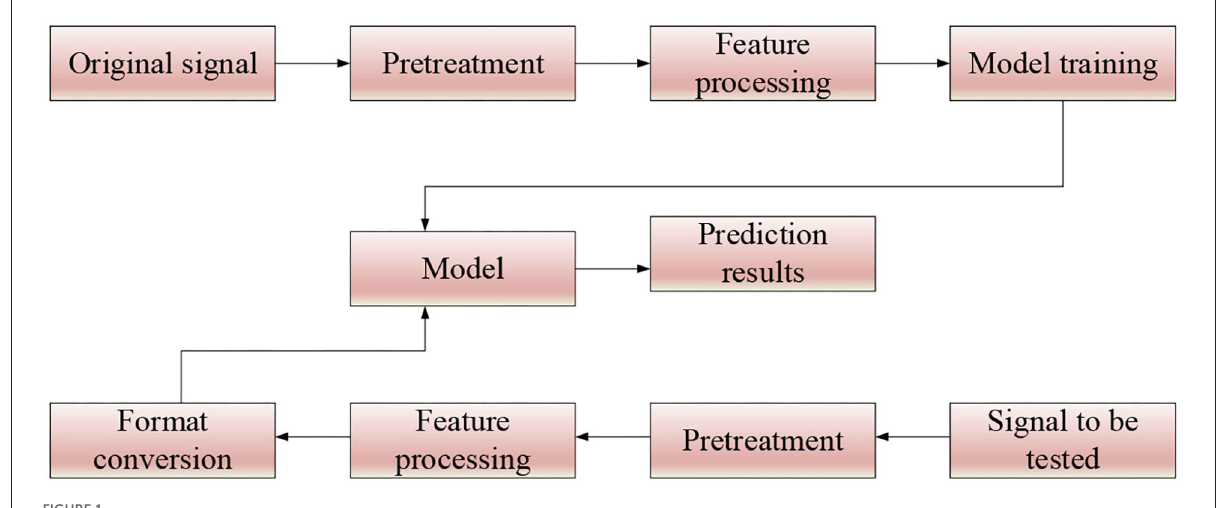
FIGURE1 Framework of proposed